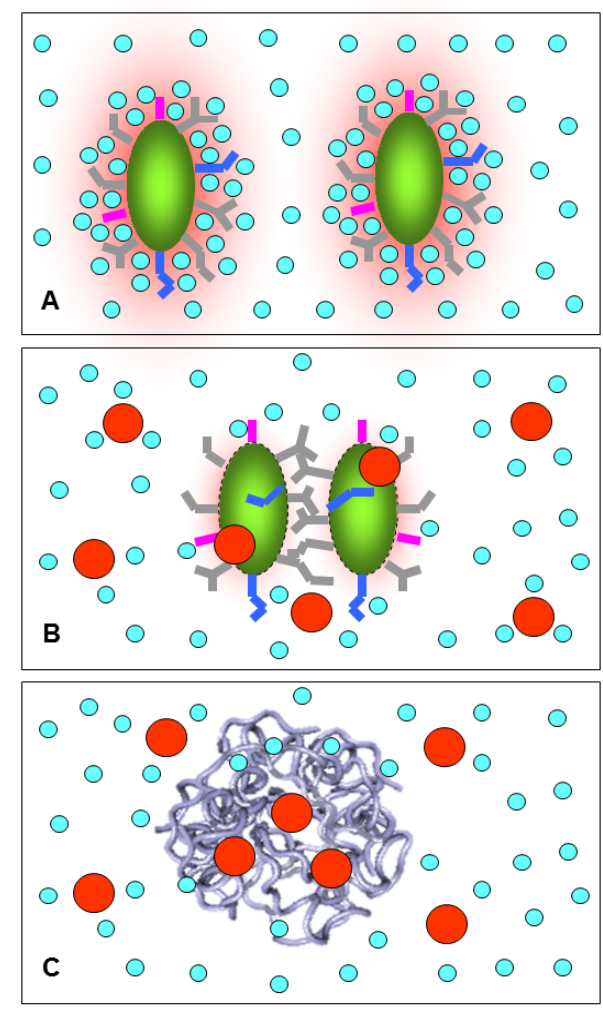
Figure 25. Modified model to rationalize how salt ions mediate protein aggregation. ( A ) An unrefoldable and insoluble protein in unsalted water with the solution pH several unites away from its pI. Small cyan spheres stand for water molecules and green ellipsoids for protein molecules with a large amount of hydrophobic side chains exposed. ( B ) Protein molecules in the presence of a small amount of salt ions (larger red spheres). In addition to imposing non-specific electrostatic screening as I previously proposed, the presence of salts also provides specific anion binding to protein residues, thus altering the surface electrostatic potential. Furthermore, salts may also changes water clustering structure as well as protein dynamics as represented by the broken lines of green ellipsoids. ( C ) The complex interplay of these salt effects may result in aggregation of the